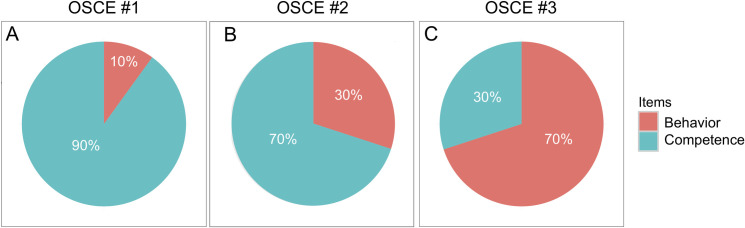
Pie charts displaying the proportions of competence-based and behavior-based items in the evaluation grids for OSCE stations #1, #2 and #3 (A, B and C, respectively). Detailed evaluation grids are provided as S1–S3 Data.